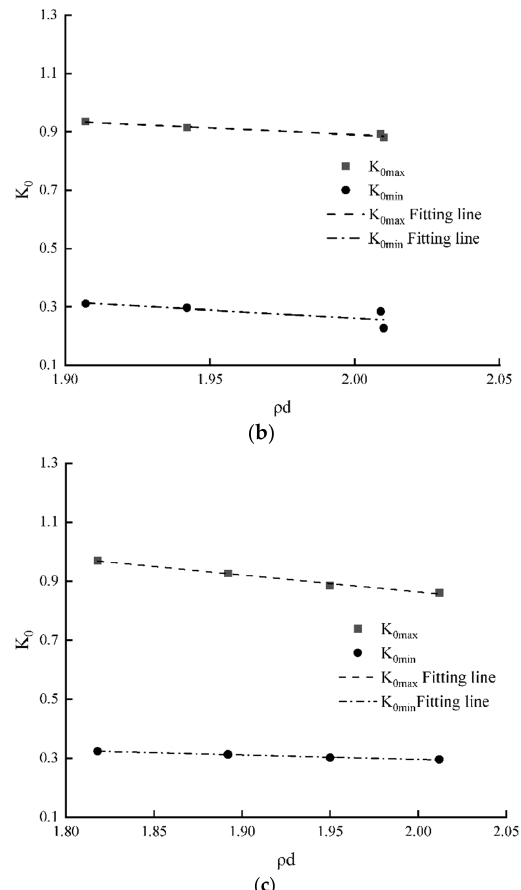
Figure 6. K 0max / K 0min – p d fitting curves of the specimens for different techniques: ( a ) scalping technique, ( b ) replacement technique, and ( c ) parallel gradation technique. Using Equation (7) to fit the sand and gravel K 0 test results above, for which the fitting curve is in accordance with Figure 7, causes the K 0 -fitted value and the test to yield a very good match error, which is less than 5%; thus, the fitting effect is good. This result shows the reliability of the empirical formula and its applicability to different dry density coarse-grained soils. Therefore, the static lateral pressure coefficient test was carried out for different dry densities of sand and pebbles, for which the parameters presented in (7) were obtained, so that the relationship between the static lateral pressure coefficient and the initial dry density and vertical stress can be better described by Equation (7).